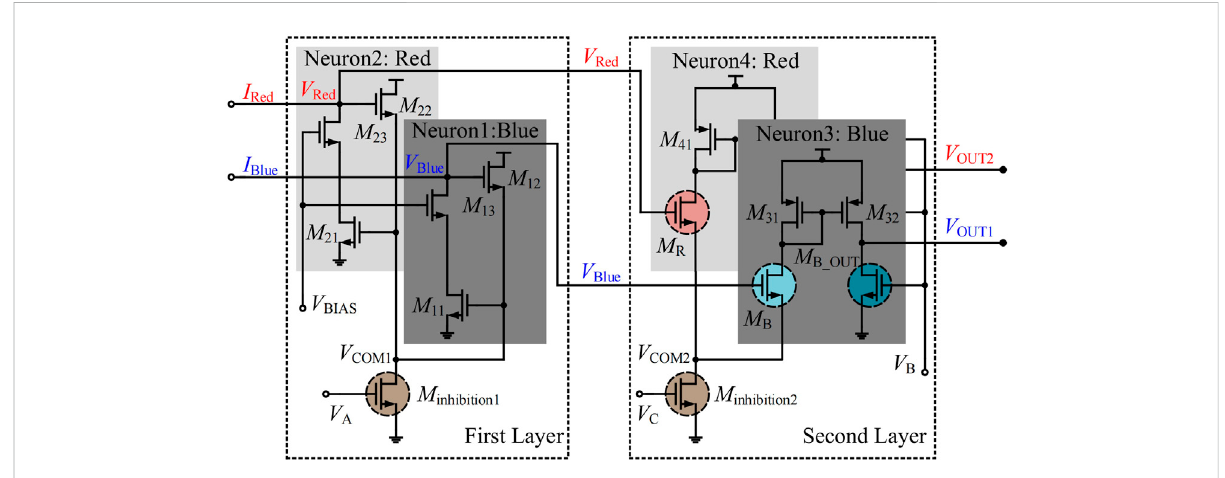
FIGURE 4 The double-branch attentional selection circuit. A higher-order signal modulation scheme can be achieved with the participation of the fi rst layer and the second layer, and the second layer of the attentional selection network can further analysis the